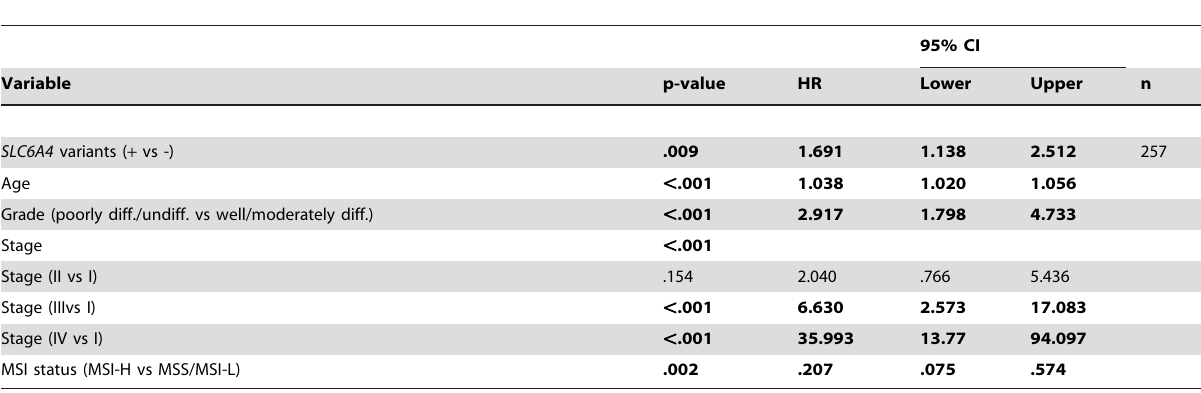
Table 6. Multivariate analysis results for the combined genotypes of three SNPs within the SLC6A4 gene (DSS).